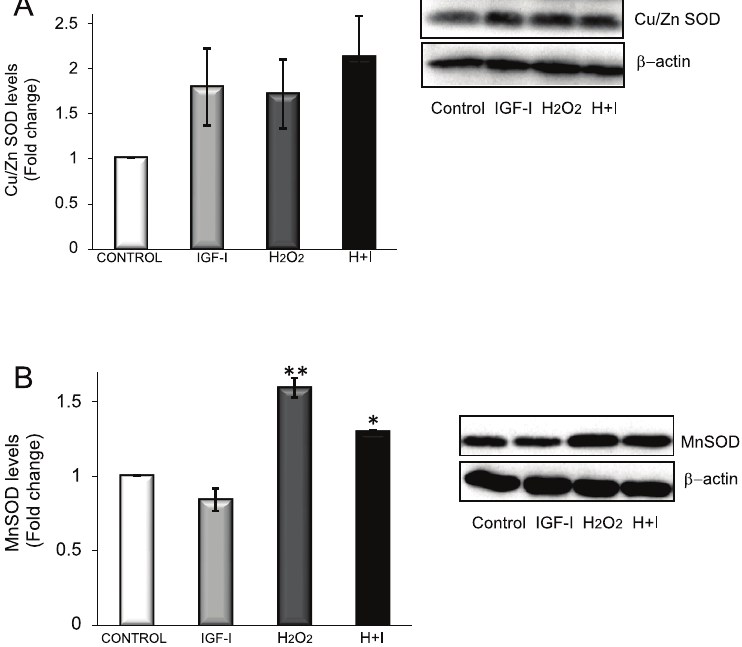
Figure 5. SOD responses to oxidative stress in astrocytes. A ) Cu/ZnSOD levels in astrocytes are modulated by IGF-I and H levels are enhanced by H